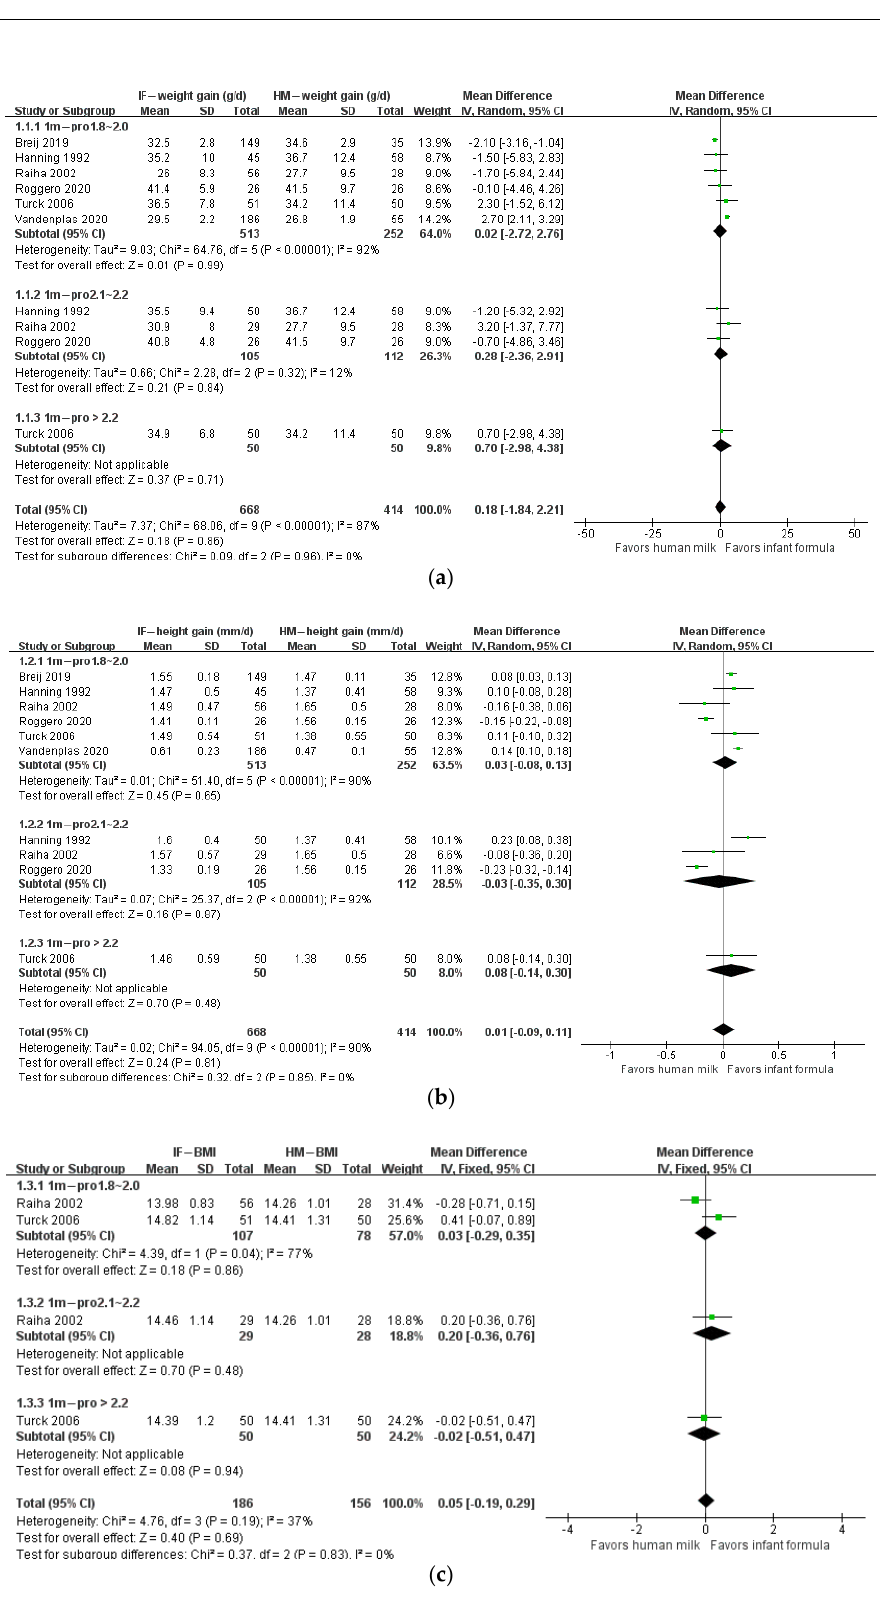
Figure 2. Forest plot of the effects of protein content of infant formula on the weight gain, height gain, and BMI of infants at 1 month of age. ( a ) The effects on weight gain. ( b ) The effects on height gain. ( c ) The effects on BMI.